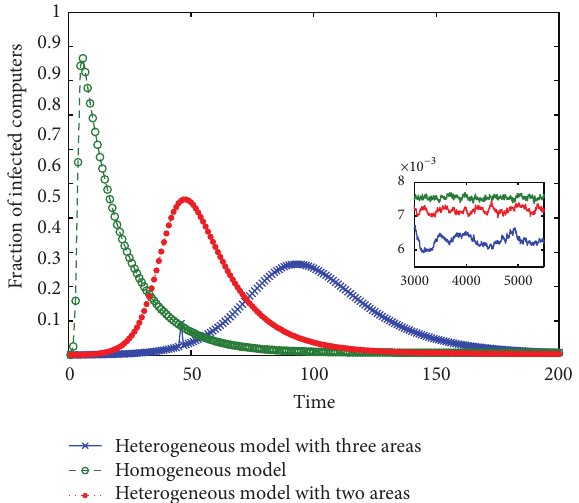
Figure 3: Fraction of infected computers based on the model in this paper (blue, heterogeneous model where three areas divided according to the removable device’s using rate are considered) compared to the counterparts based on the model presented in [9] (green, homogeneous model) and in [13] (red, heterogeneous model where two areas are considered).